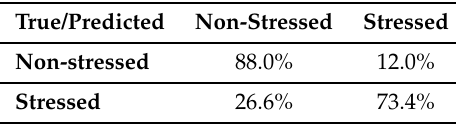
Table 3. Confusion matrix, when user-independent regression model based on BVP and ST features is used for stress detection.